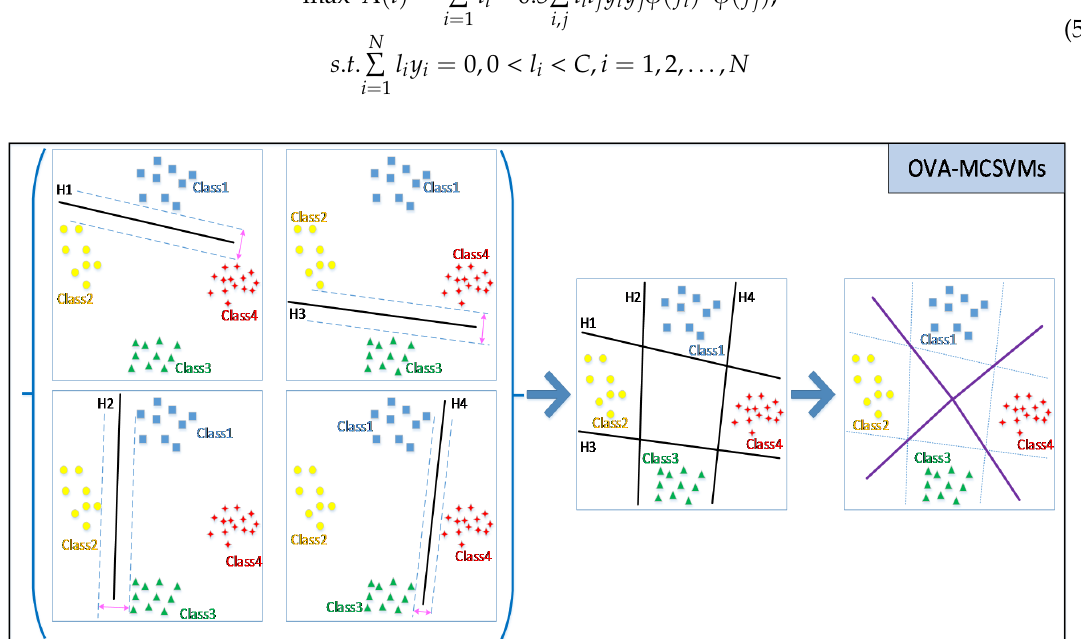
Figure 3. An example of four-class classification scenario and true decision boundaries using the one- versus-all multi-class support vector machine